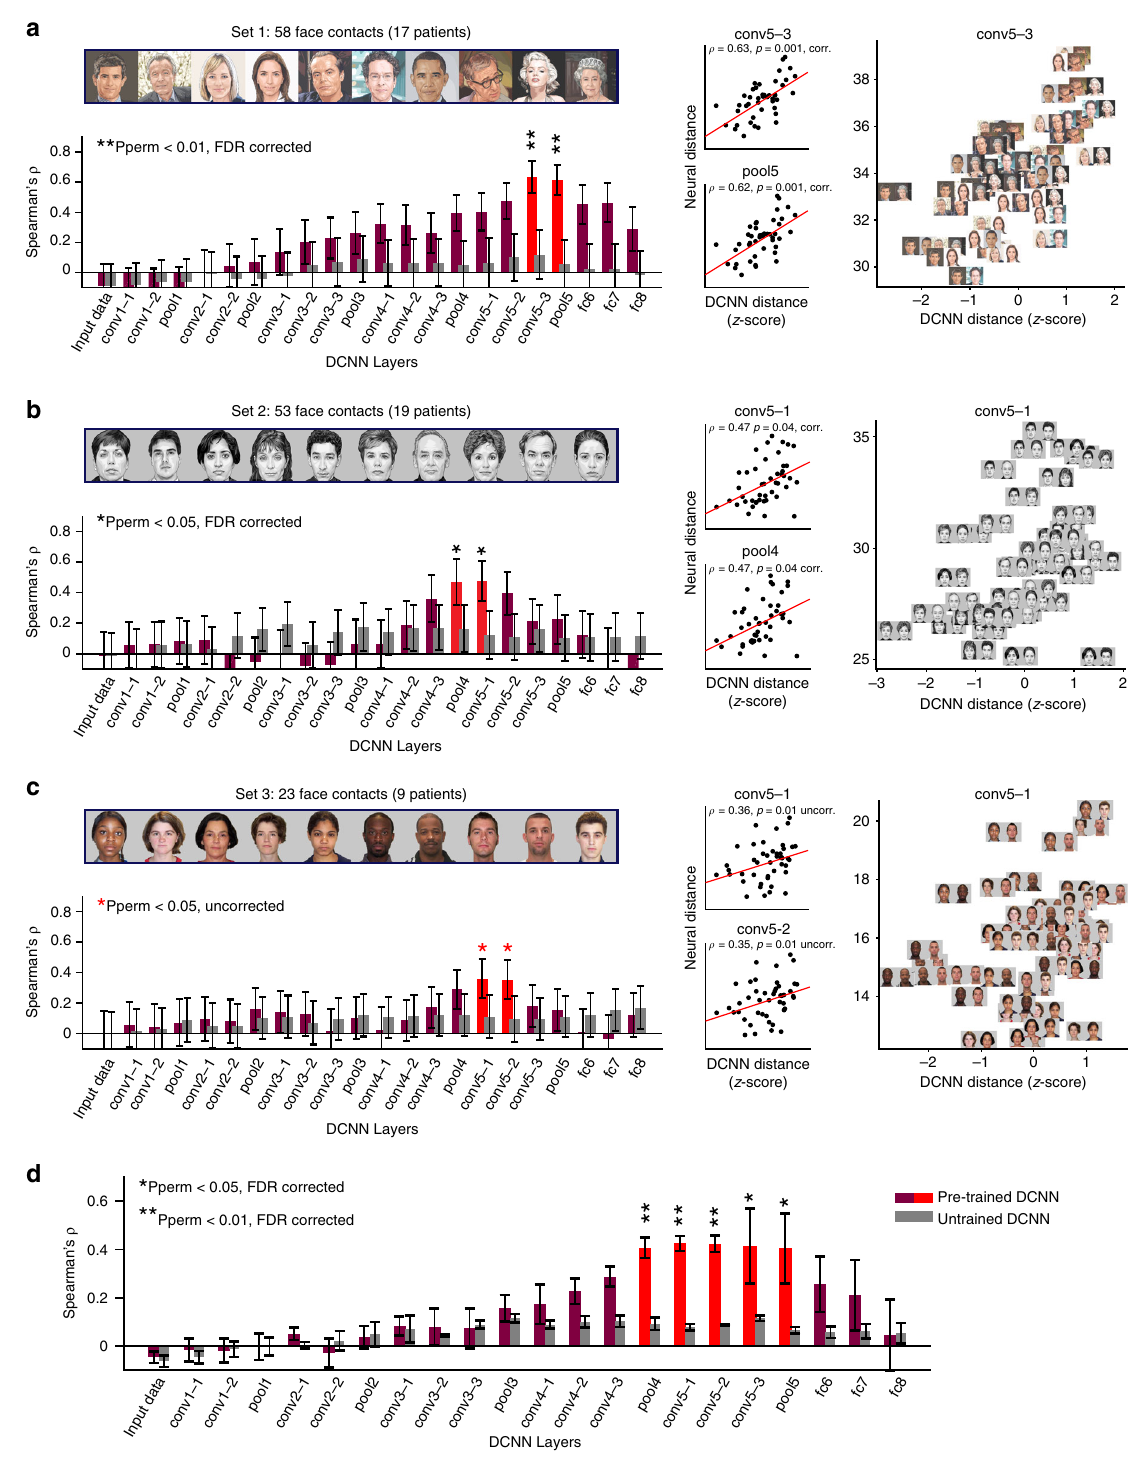
those obtained from 1000 image permutations, all p > 0.27; see Supplementary Fig. 9 for sets 2 and 3). Conversely, presenting the DCNN with the same identities but in a different appearance (e.g. facial expression, haircut), and the same identities in similar appearance but with partial (~45°) head rotation — manipulations that change pictorial aspects while maintaining personal identity — signi fi cantly reduced the correla- tion (pale orange bar and blue bar, respectively). Moreover, a ~90° rotation to a pro fi le view completely abolished the